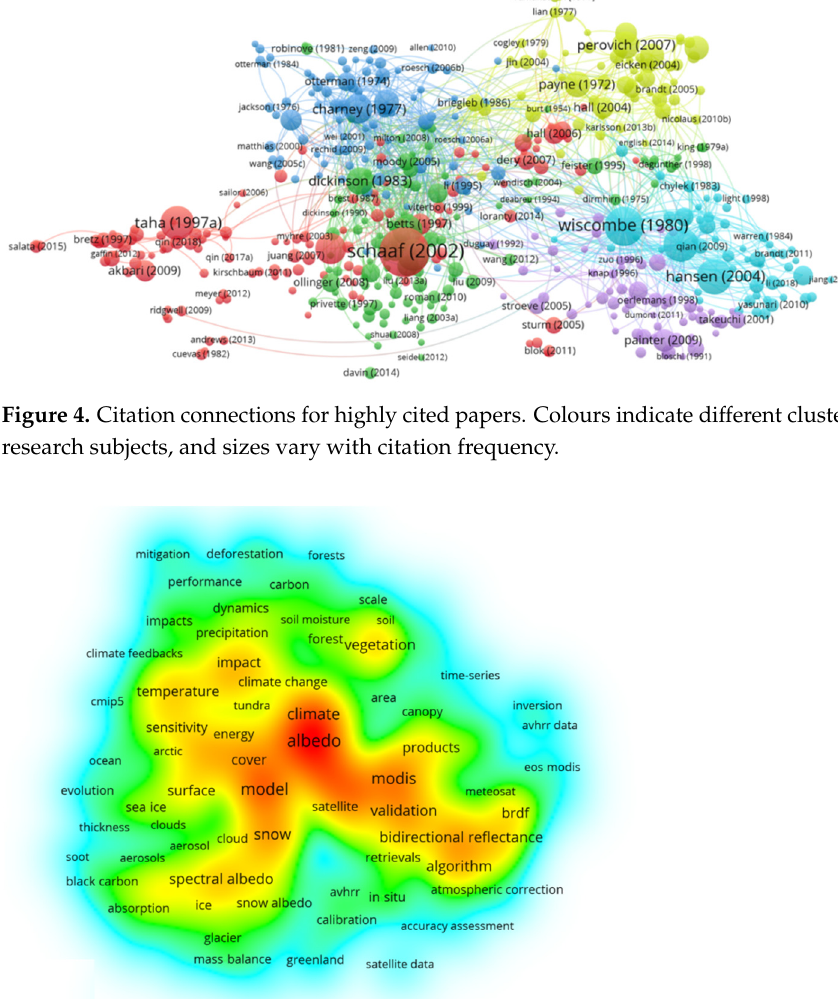
Figure 4. Citation connections for highly cited papers. Colours indicate different clusters with sim- ilar research subjects, and sizes vary with citation frequency.